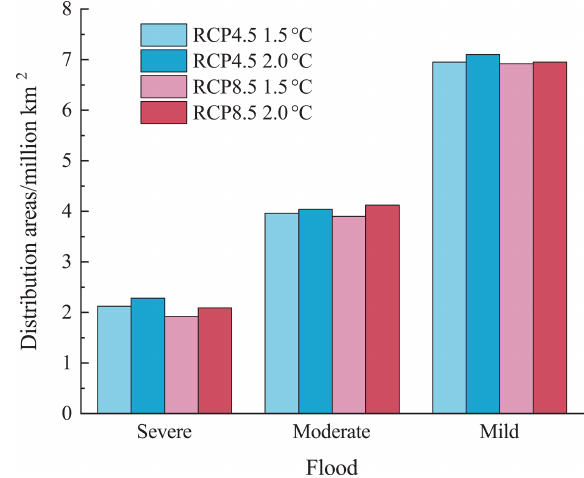
Figure 1. Distribution areas of severe, moderate and mild floods for 1.5 and 2 ◦ C of global warming (units: millions of square kilome-